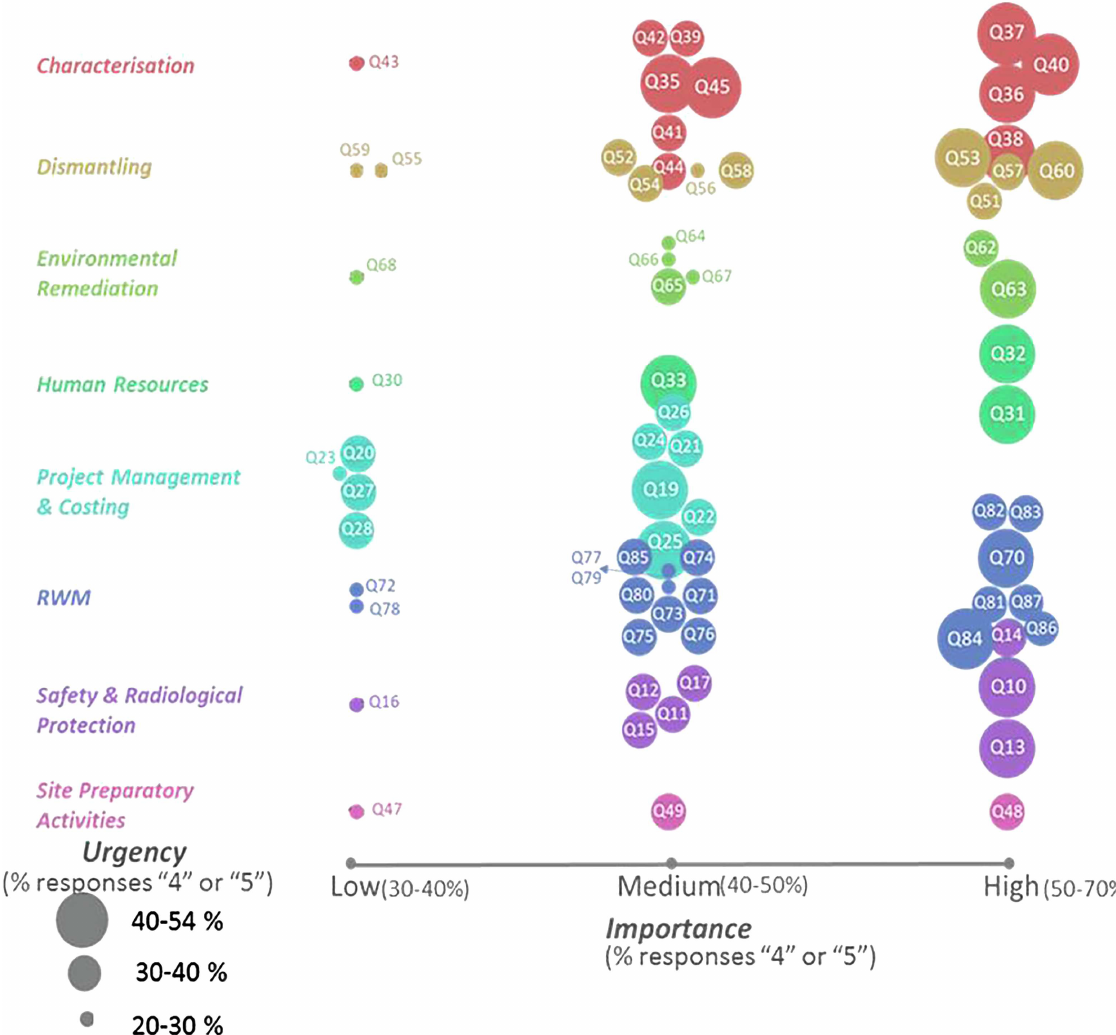
Fig. 8. Importance and urgency rating of the subthematic